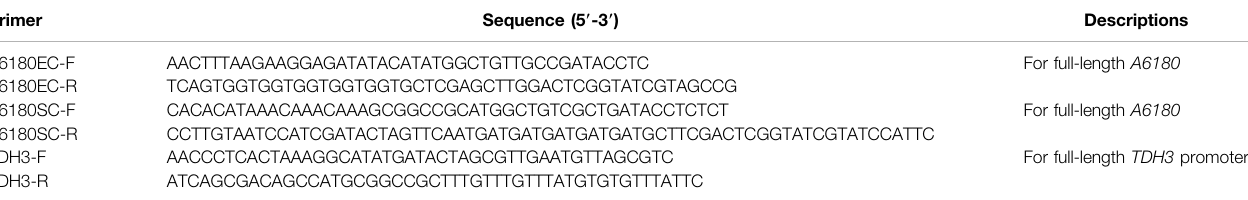
TABLE 1 | Primer design of the Hericium erinaceus A6180 gene and related functional fragment.